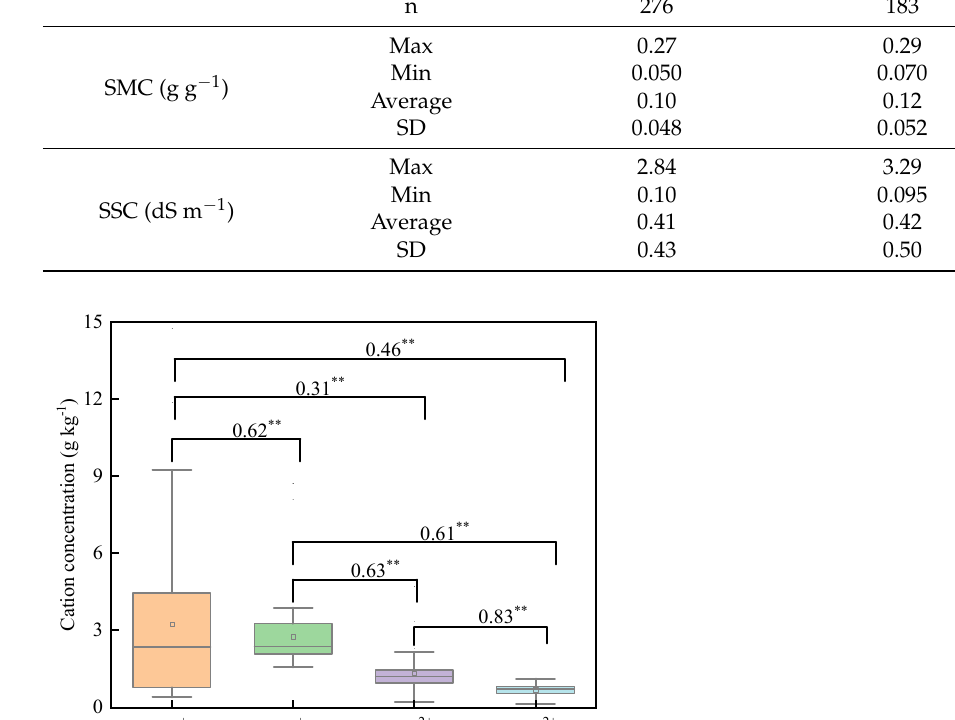
Table 2. Statistics of SMC and SSC for the calibration and validation datasets used in this study. Calibration Dataset Validation Dataset